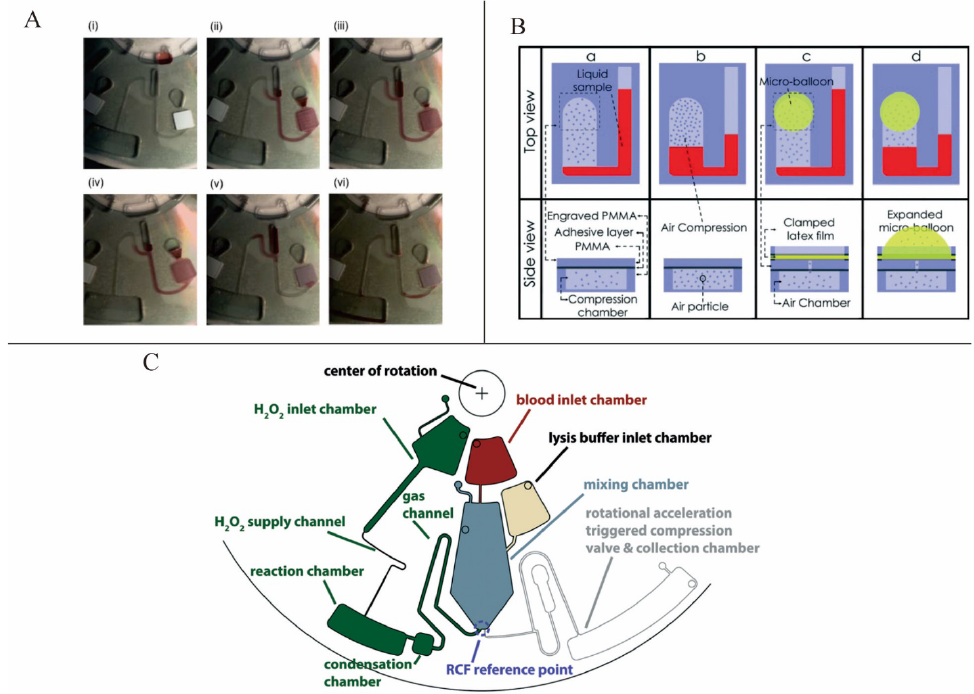
Figure reprinted with permission from [29]. ( C ) Buoyancy driven bubble mixing.